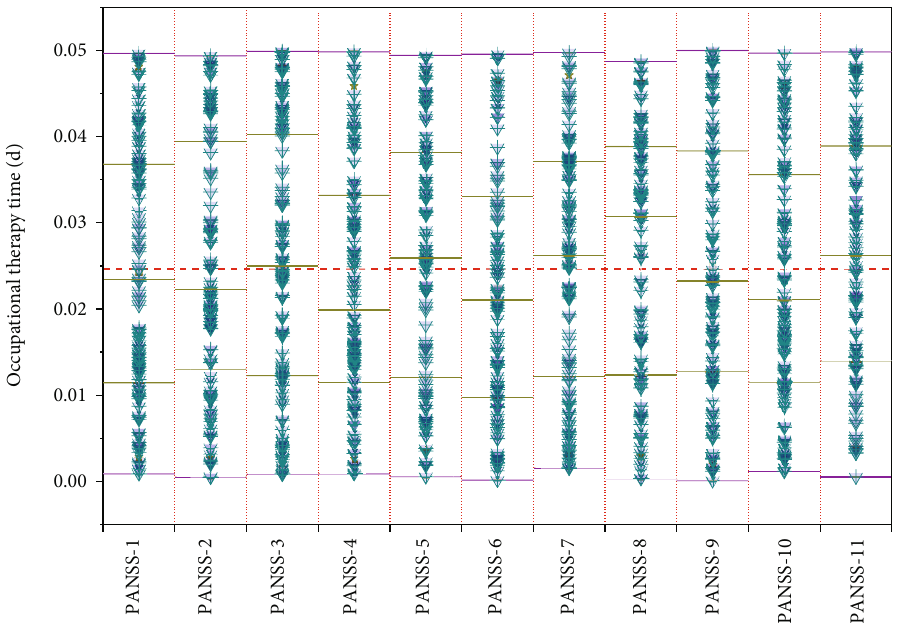
Figure 8: Analysis of occupational therapy data for college